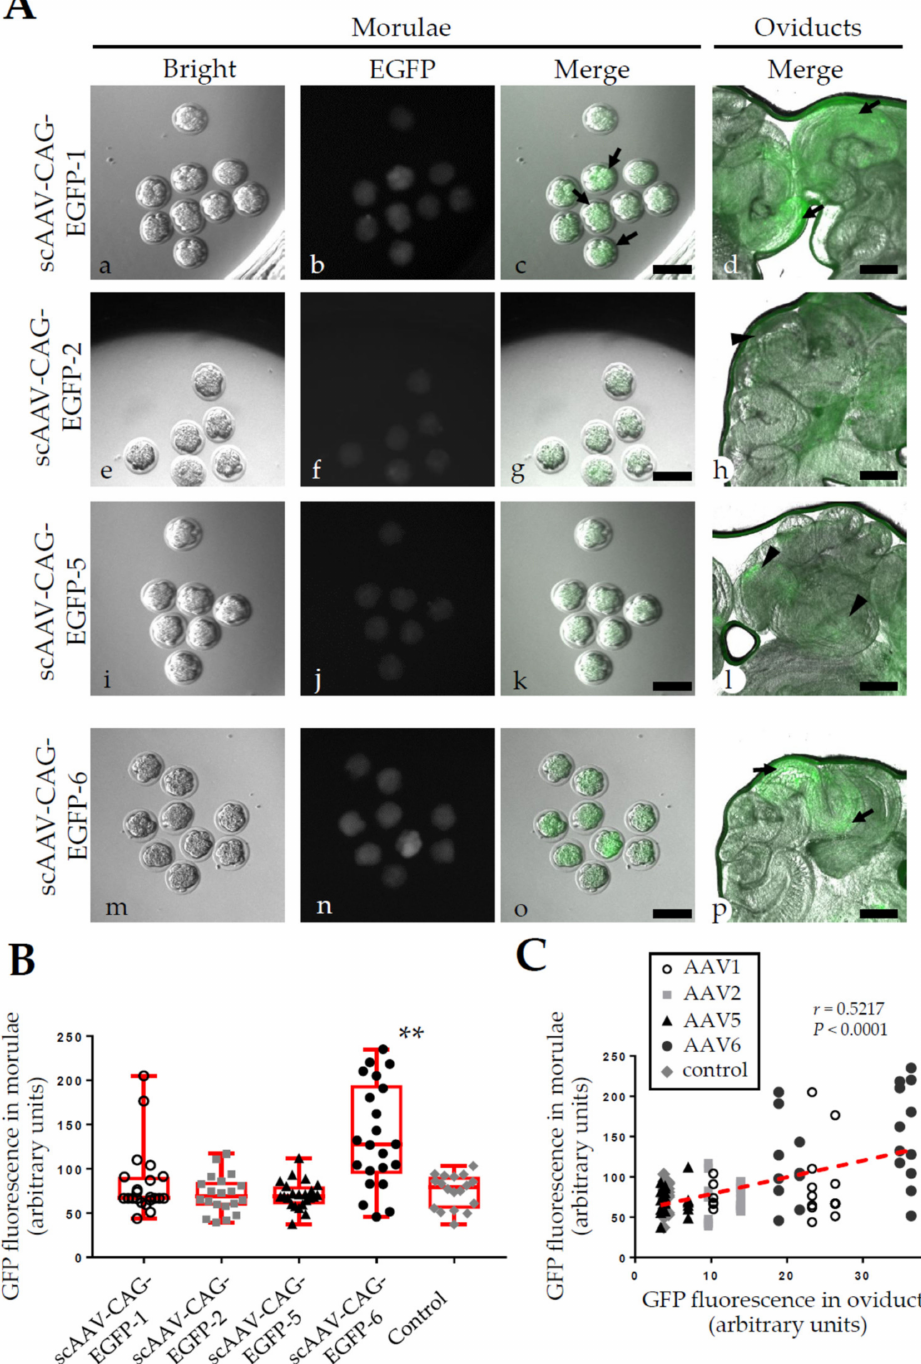
Figure 2. Tropism of rAAV-1, -2, -5, and -6 for mouse embryos and oviducts. ( A ) Monitoring of fluorescence in morulae ( a – c , e – g , i – k , m – o ) and oviducts ( d , h , l , p ) 2 days after AAV-based GONAD in pregnant B6C3F1 females using scAAV-CAG-EGFP-1, -2, -5, and -6. Bright, photographs taken under white light; EGFP, photographs taken under blue light illumination; Merge, mixed images of white and blue light illumination. Scale bars, 100 µ m ( a – c , e – g , i – k , m – o ) and 500 µ m ( d , h , l , p ). ( B ) Quantification of GFP expression in individual morulae treated with different serotypes of the rAAV vectors. The box and whisker plots with maximum and minimal ranges correspond to all data points analyzed. A Kruskal–Wallis test with Dunn’s multiple comparisons revealed a significant difference between